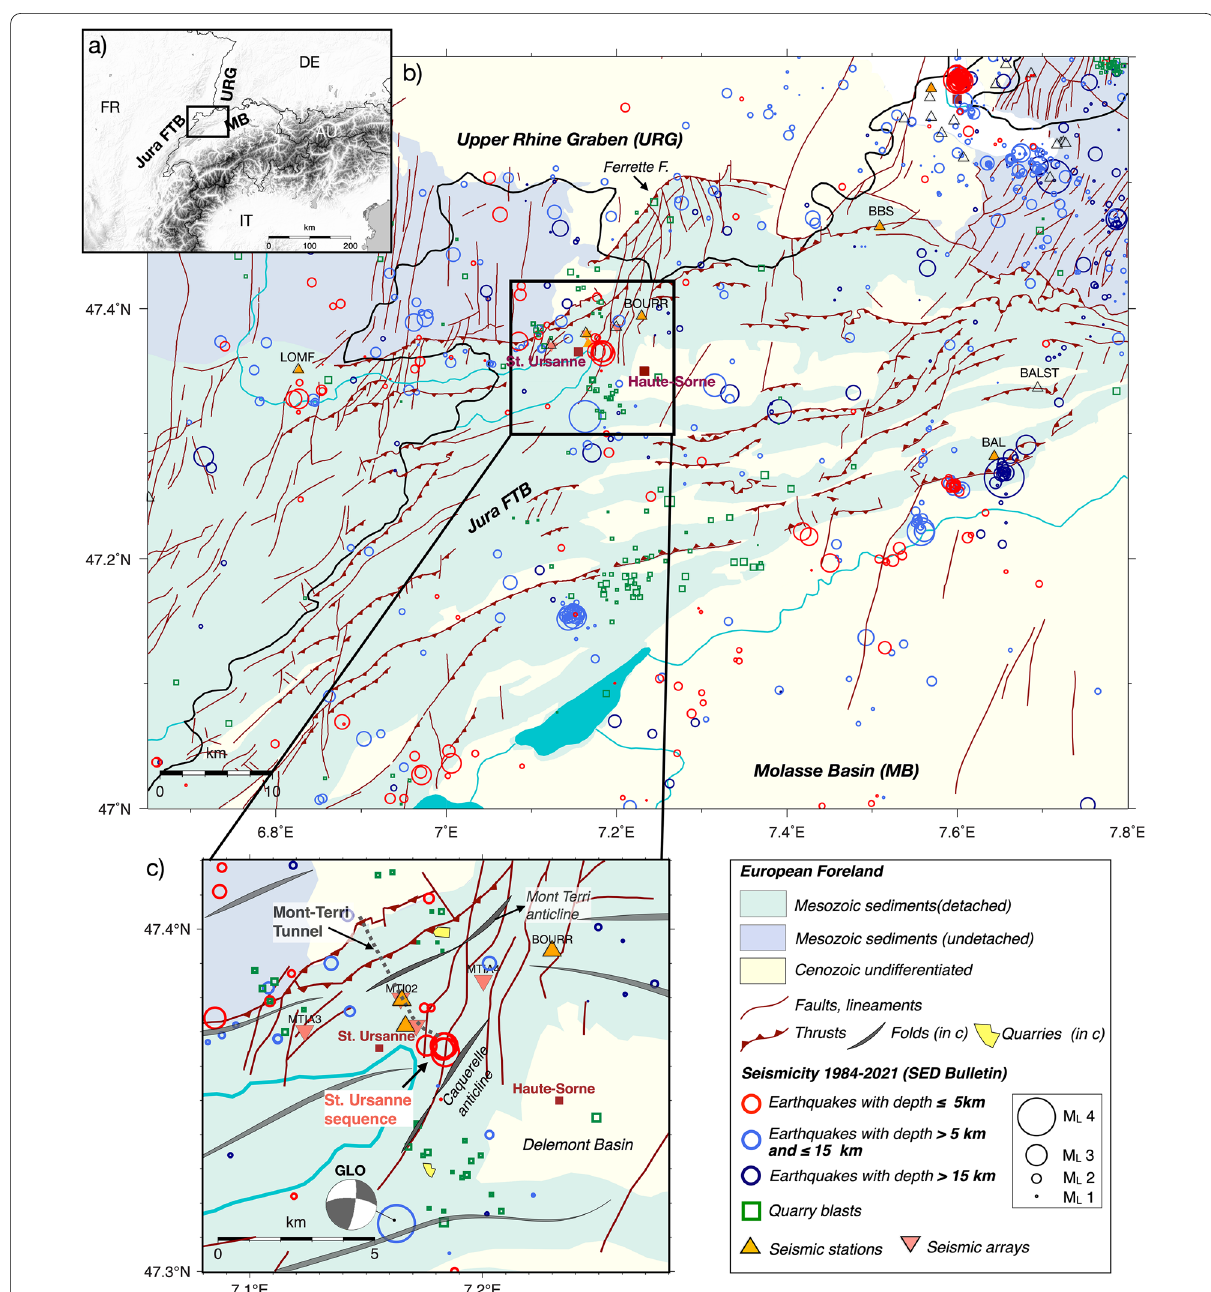
Fig. 1 a Location of the study area within Switzerland. The inner inset corresponds to the tectonic map in ( b ). b Tectonic map with the main units, fault systems, seismicity and seismic stations in the northern part of the Jura FTB. Faults and fold systems are from swisstopo database (Swisstopo, 2005). Circles indicate earthquakes as listed in the bulletin of the Swiss Seismological Service (SED) between 1984 and 2021 with colors indicating focal depths (see legend). Green squares indicate identified quarry blasts. c Zoom in of the area of investigation with the location of the Mont Terri tunnel (dashed line) and the quarries (yellow polygons)